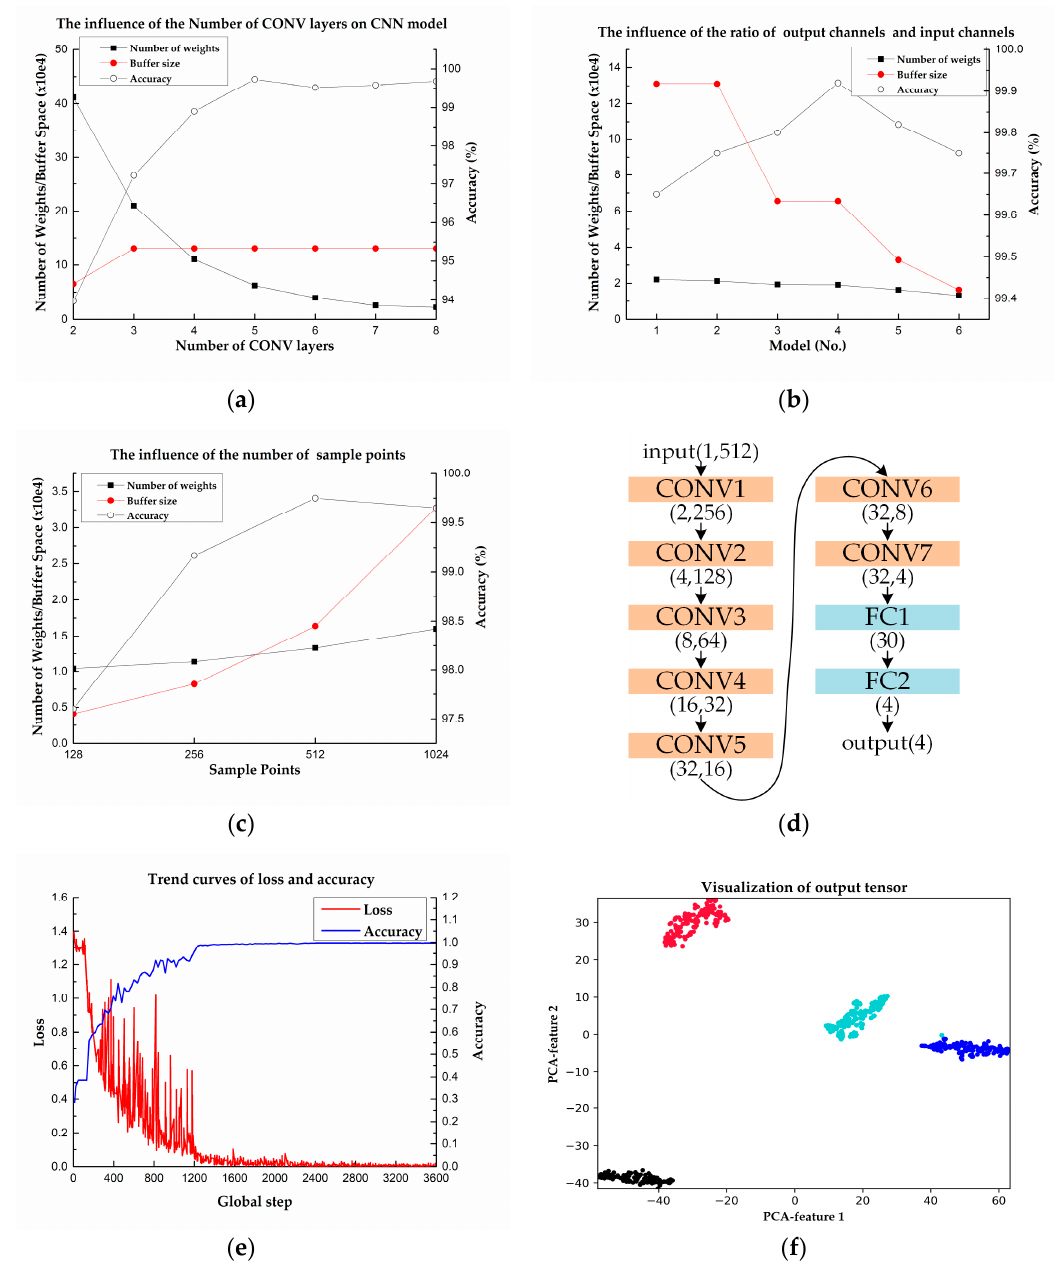
Figure 8. CNN network model design and parameter reduction. ( a ) The effects of the number of CONV layers on CNN model. ( b ) The effects of the ratio of output channels and input channels. ( c ) The effects of the number of sample points of input tensor. ( d ) The CNN model which has relative high accuracy, less required buffer size, and a few parameters. ( e ) The trend curves of loss and accuracy during training. ( f ) Visualization of FC1 ʹ s output tensor.